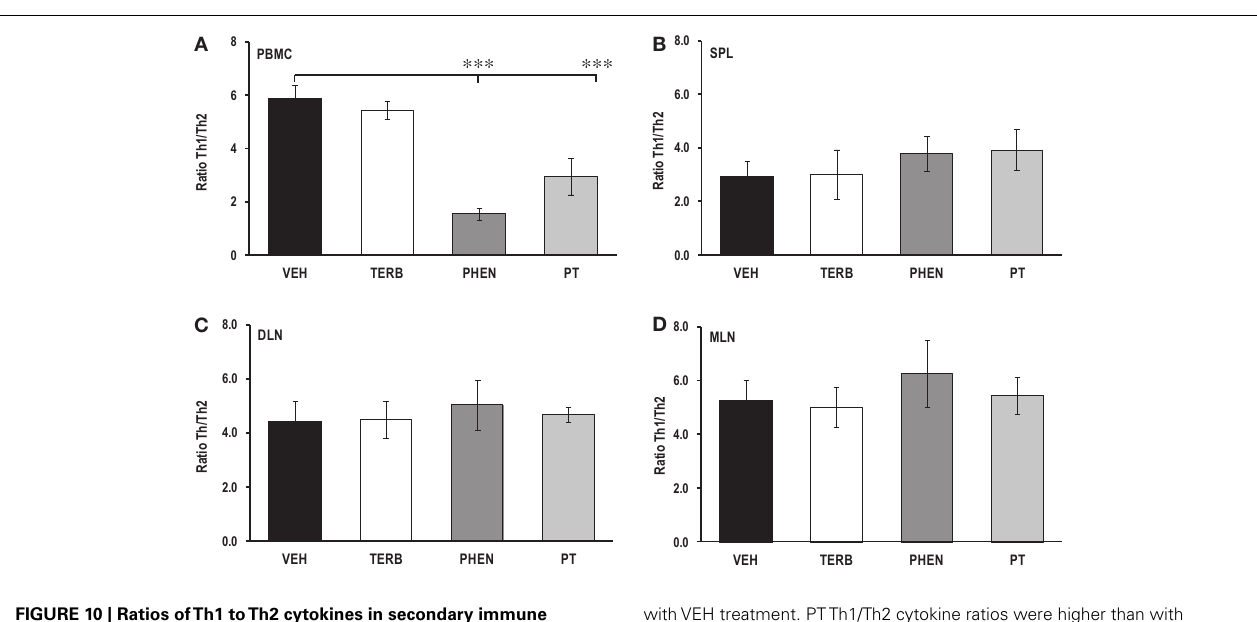
FIGURE 10 | Ratios ofTh1 toTh2 cytokines in secondary immune compartments . Animals were treated with twice-daily i.p. injections of vehicle (VEH, black bars), terbutaline (TERB, white bars), phentolamine (PHEN, dark gray bars), or phentolamine and terbutaline (PT, light gray bars) initiated 12days after adjuvant challenge. (A) PBMC: PHEN and PT treatments lowered theTh1/Th2 cytokine ratio in PBMC cultures compared